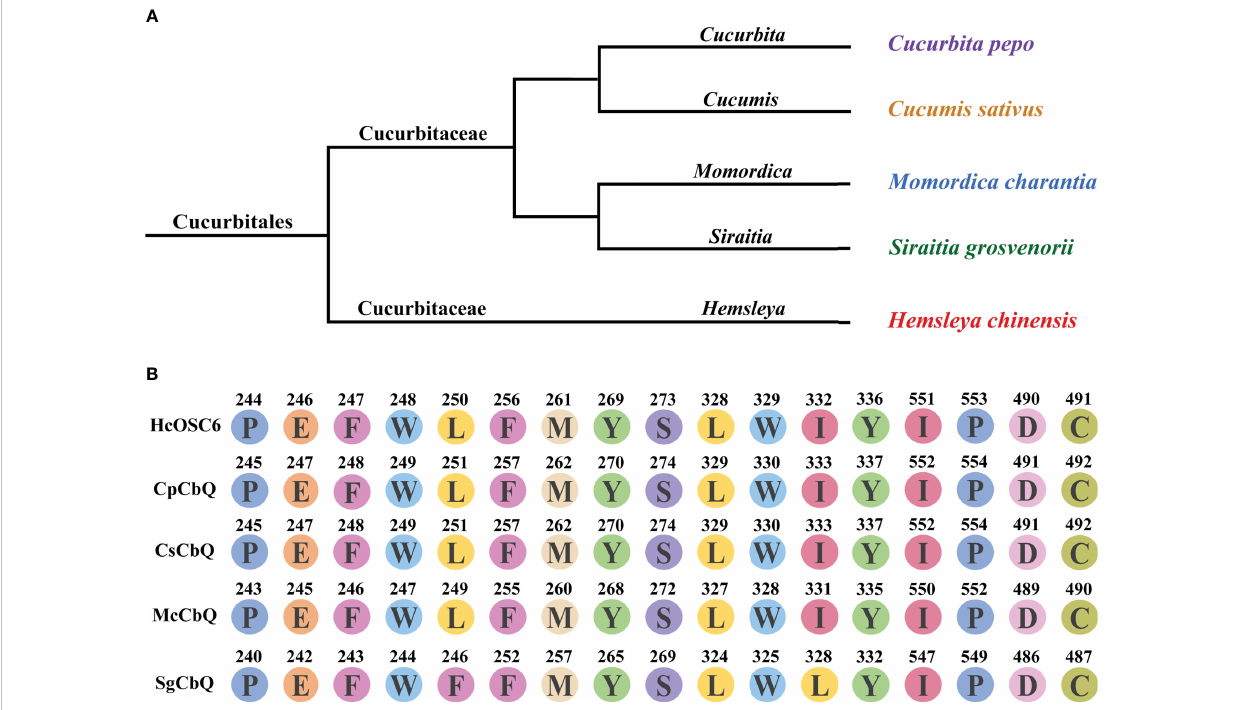
FIGURE 6 Divergence of HcOSC6 contributes to Hemsleya in Cucurbitales. (A) Phylogenetic relationship of fi ve analyzed plant species, originated from the Cucurbitaceae family. (B) Summary of key residues in the selected sequences. Data was extracted from the OSCs alignment from fi ve species. Functionally characterized enzyme names are labeled in black; Branch colors